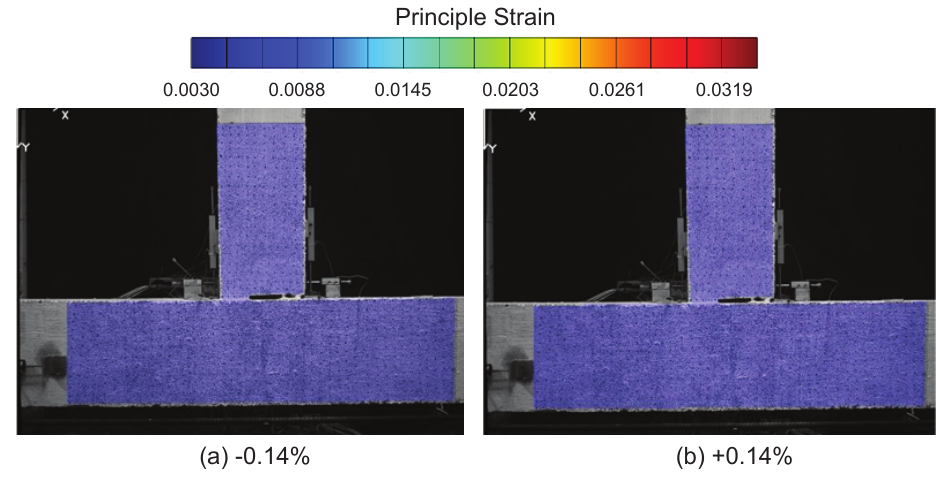
Figure 4. DIC results at a drift level of ±0.14%. From top to bottom along the beam, the gradual increase in strain in the optical fibers indicates increasing curvature along the beam caused by increasing moment. The asymmetric behavior of the beam is clear when comparing the maximum tension under loading in different directions (Beam Left in Figure 6 with positive drift and Beam Right in Figure 5 with negative drift): the maximum tension was higher when the slotted side (right side in Figure 3) underwent tension. More specifically, at the same drift level, the maximum tensile strain on the right side was ~2000 micro strain (Figure 6), while the maximum tensile strain was only ~500 micro strain on the left side (Figure 5), caused by the concentration of deformation near the